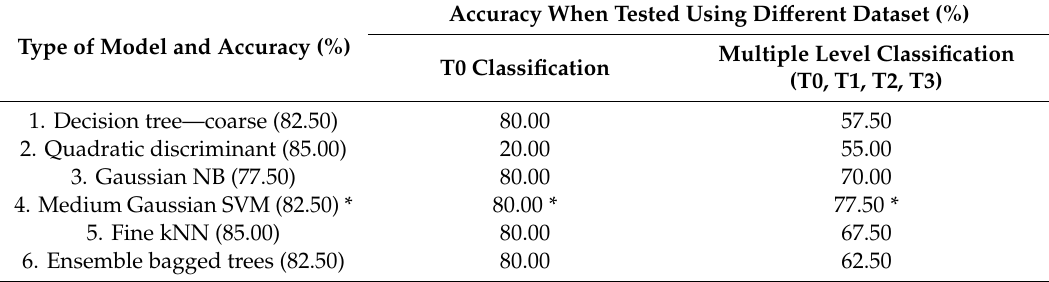
Table 5. Results of the classification model using PC1 and PC3 (variance of 71.45%).